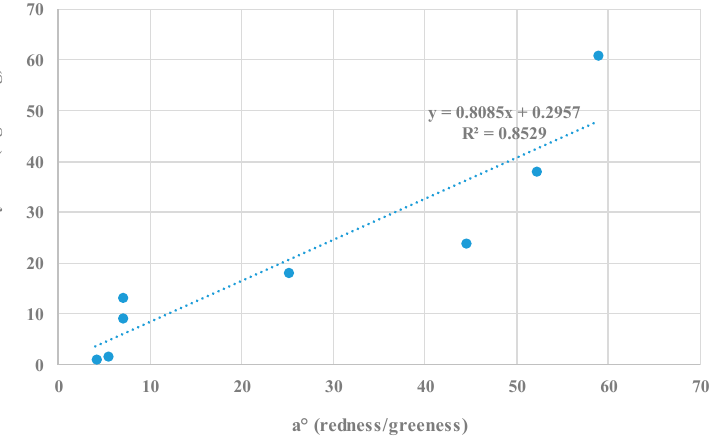
Figure 4. Correlation between color coordinate a° and total anthocyanin content of fresh and dry petals from Rosa rugosa cv. Alba and cv. Rubra.